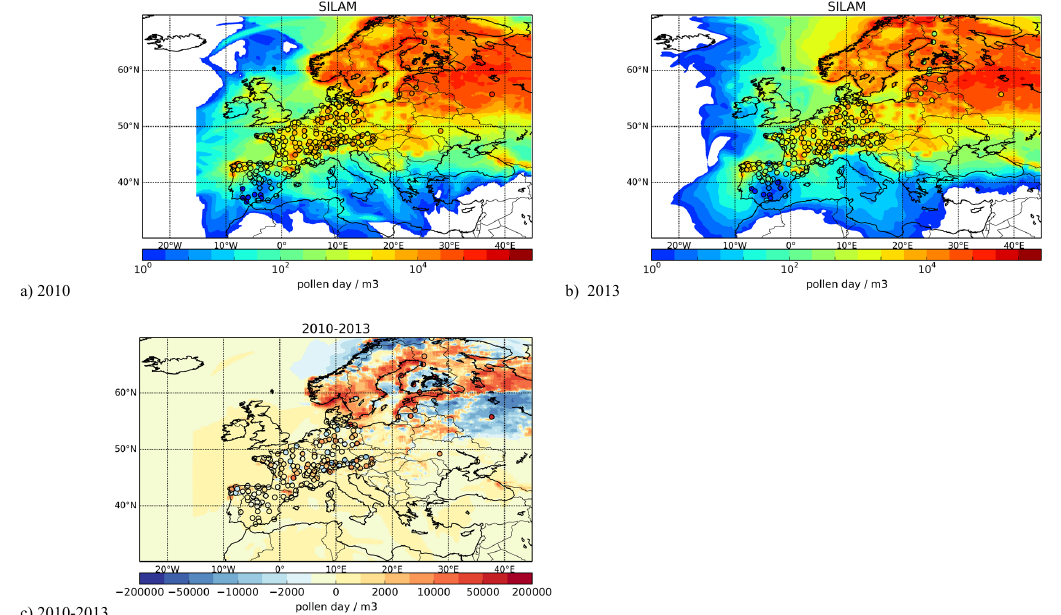
Figure 3. Seasonal pollen index in 2010 (a) and 2013 (b) and the difference, 2010–2013 (c) ; observed at the EAN stations (coloured dots) available for the study and predicted by SILAM (fields).